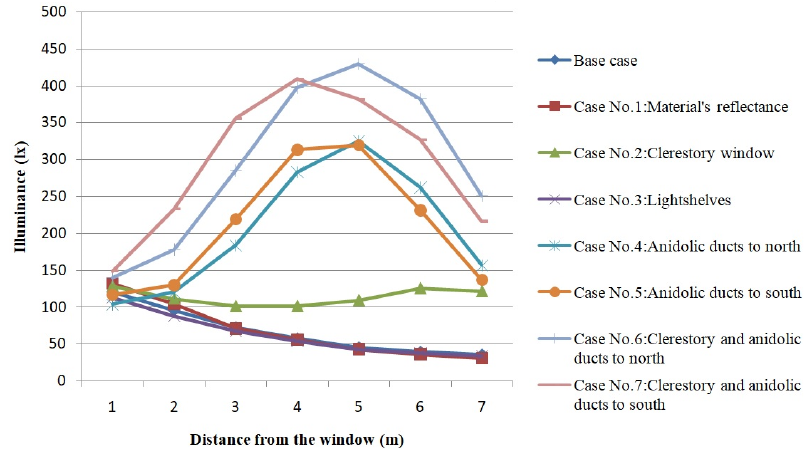
Figure 15. Comparison of average illuminance levels on the desks plane on 21 st of March at 9:00 am.